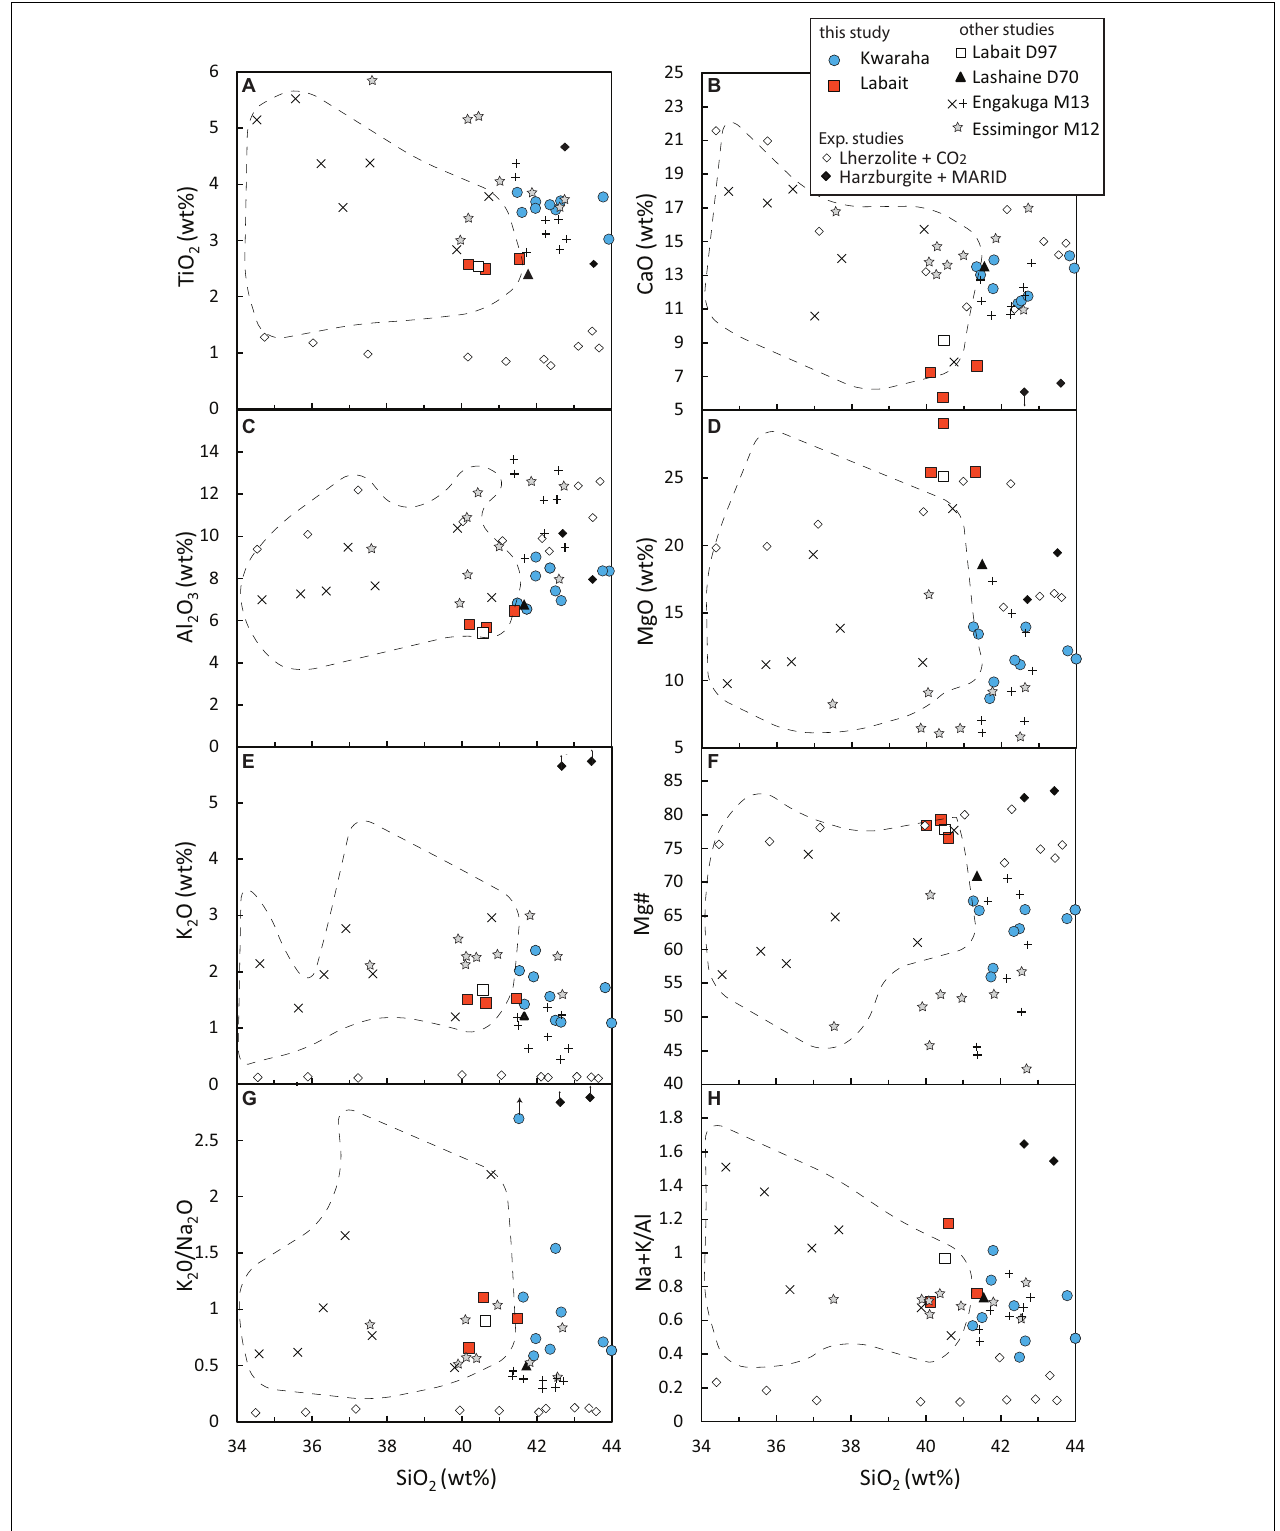
FIGURE 4 | Major element variation diagrams of sampled lavas from Kwaraha and Labait (A) TiO 2 , (B) CaO, (C) Al 2 O 3 , (D) MgO, (E) K 2 O, (F) Mg#, (G) K 2 O/Na 2 O, and (H) Na + K/Al vs. SiO 2 content. Continental melilitite compositions (dashed line) are from the Georoc database (http://georoc.mpch-mainz.gwdg.de/georoc/). All other symbols are as in Figure 3